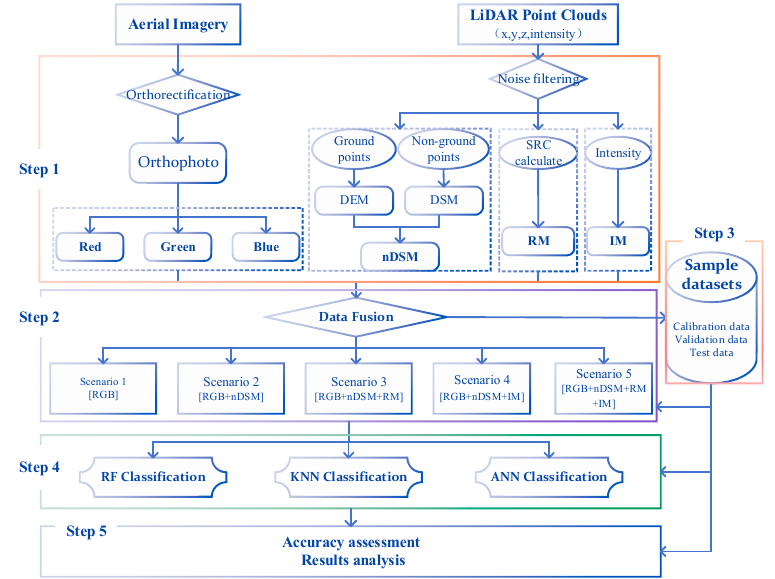
Figure 2. Study workflow.